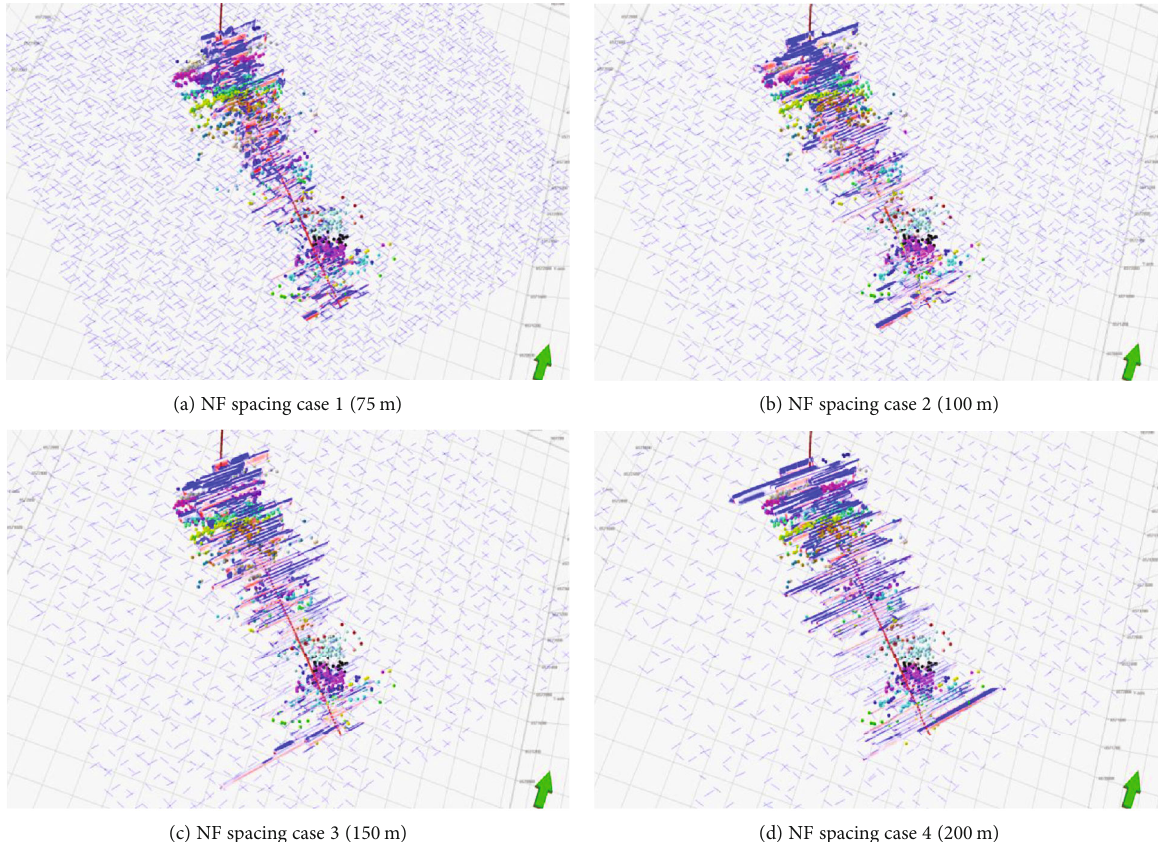
Figure 12: Fracture simulation results of di ff erent NF spacing.